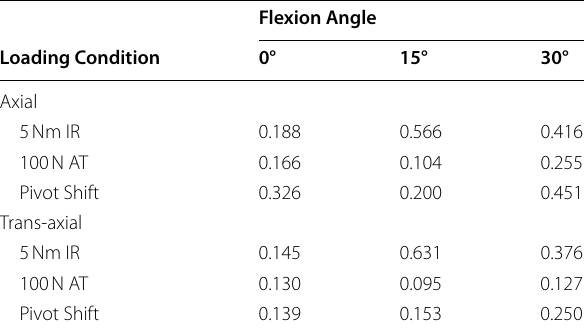
Table 4 Effect sizes for each of the loading conditions across the three knee flexion angles